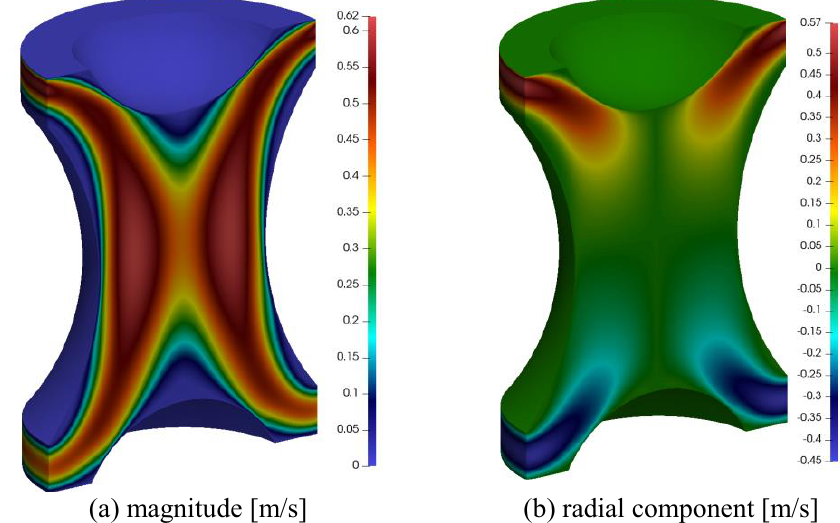
Figure 5. Velocity distribution predicted by Nek5000 for the hourglass problem showing both the magnitude and transverse